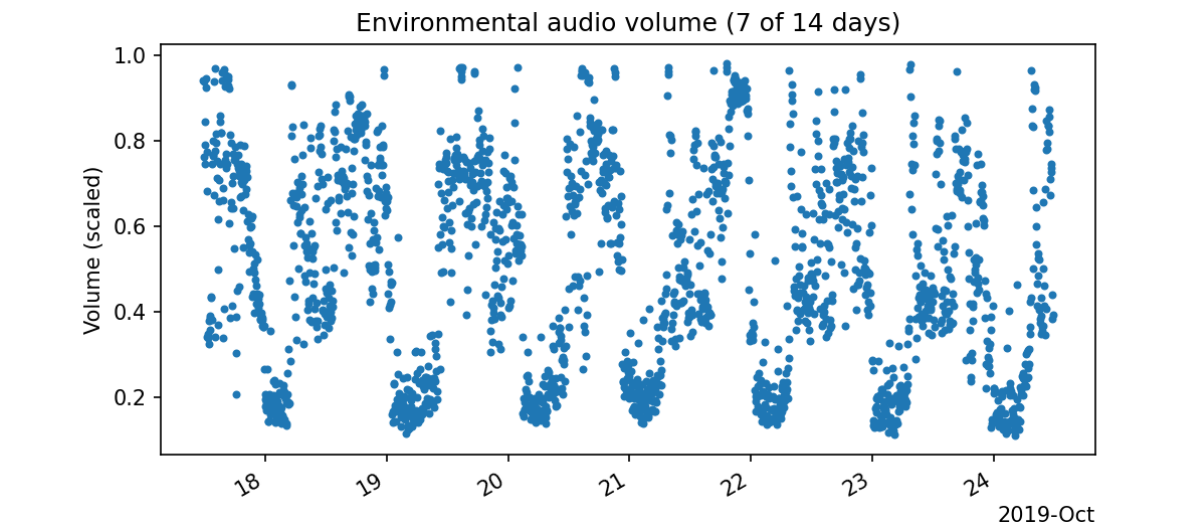
Figure 1. Visualization of a subject's environmental audio volume data (7 of 14